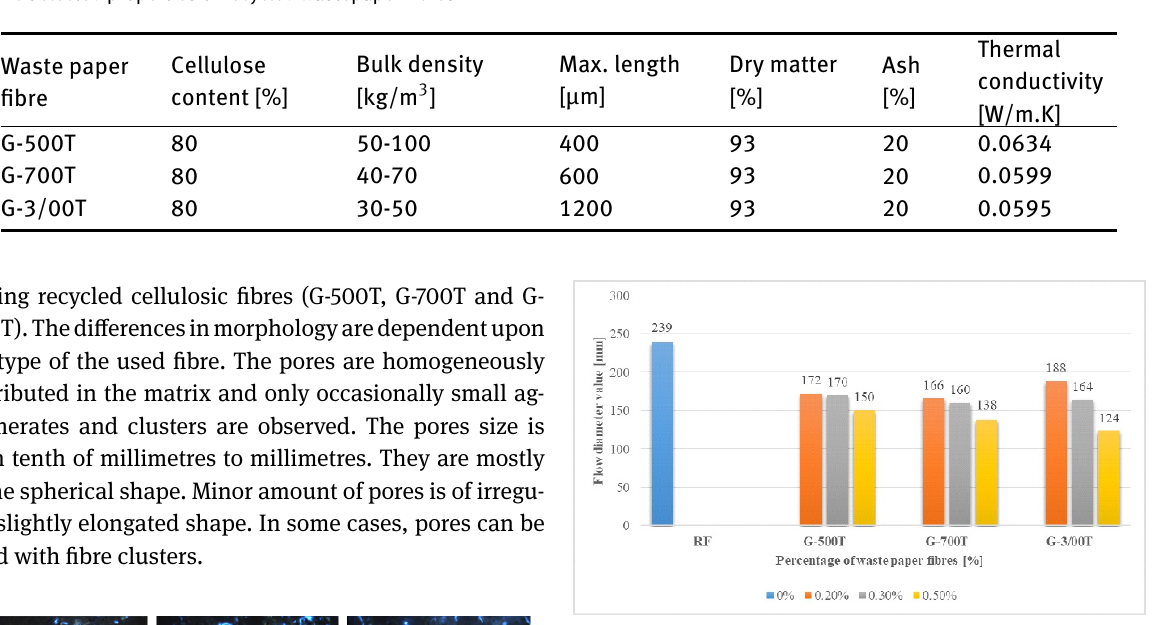
Table 1: Selected properties of recycled wastepaper fibres